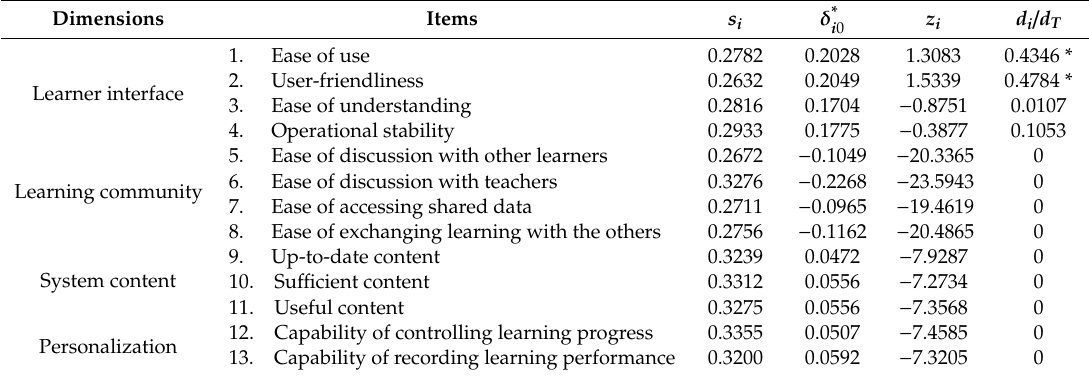
Table 2. Importance and satisfaction survey for computer-assisted language learning (CALL)